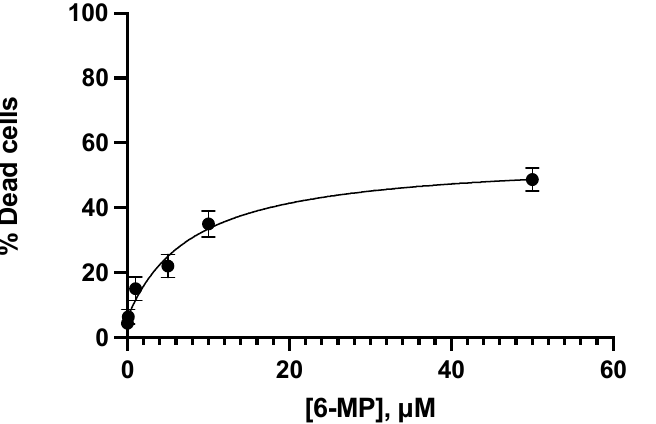
Figure 4. Concentration–response of different concentrations of 6-MP in Jurkat cells at 24 h of treatment to test cell viability. Mean +/ − SE are shown in each point. Percentage of dead cells were identified by trypan blue.